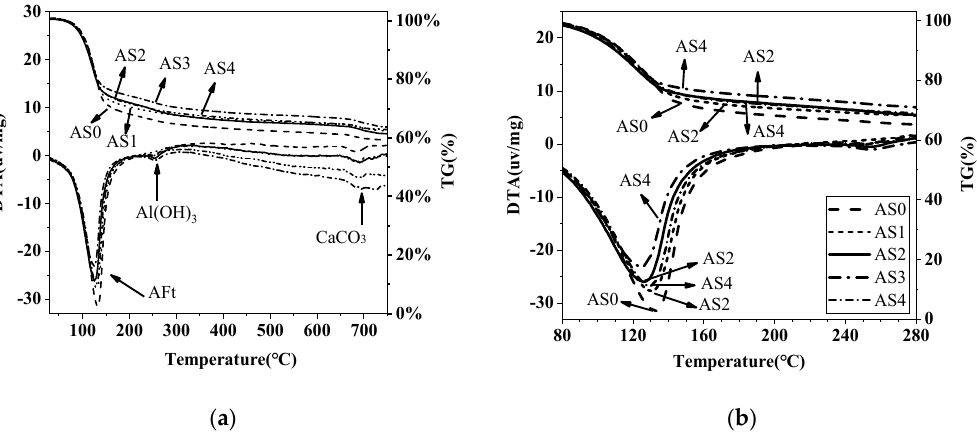
Figure 14. TG-DTA curves of the double liquid grouting materials with different aluminum sulfate content at 28 days: ( a ) Temperature ranges from 40–750 °C; ( b ) Temperature ranges from 80–280 °C. Table 6. Weight loss of the double liquid grouting materials with different aluminum sulfate content.